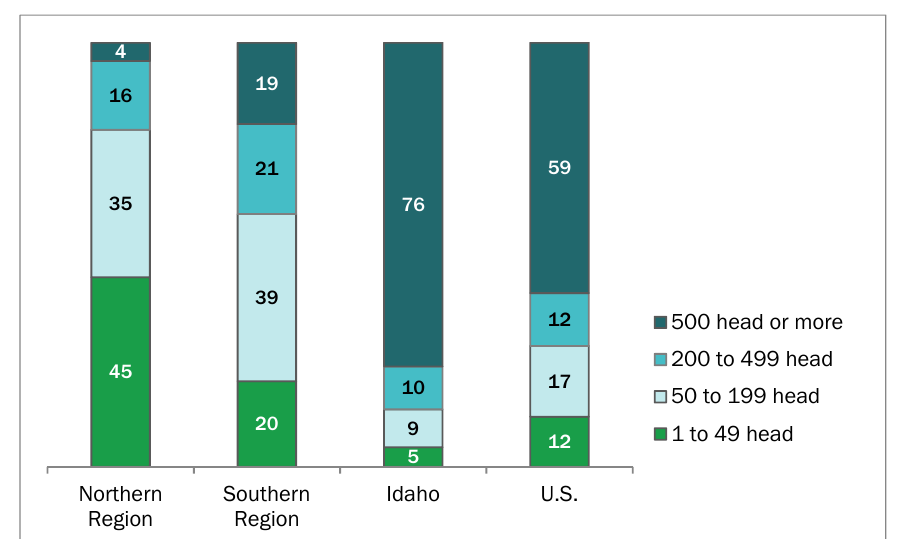
Figure 4. Distribution of Cattle and Calves Sold (%), by Number Sold by Operation in